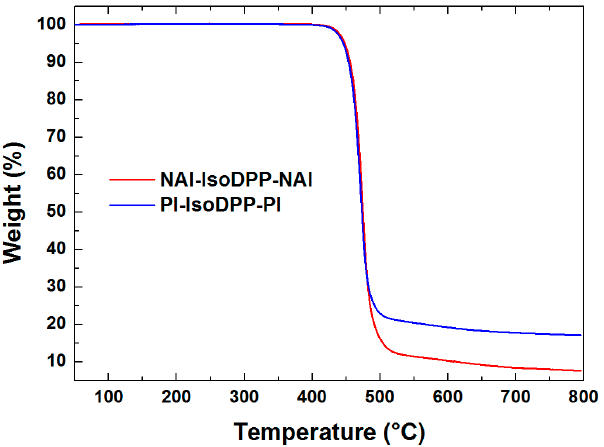
Figure 1. Thermogravimetric analysis (TGA) thermograms of NAI-IsoDPP-NAI and PI-IsoDPP-PI.